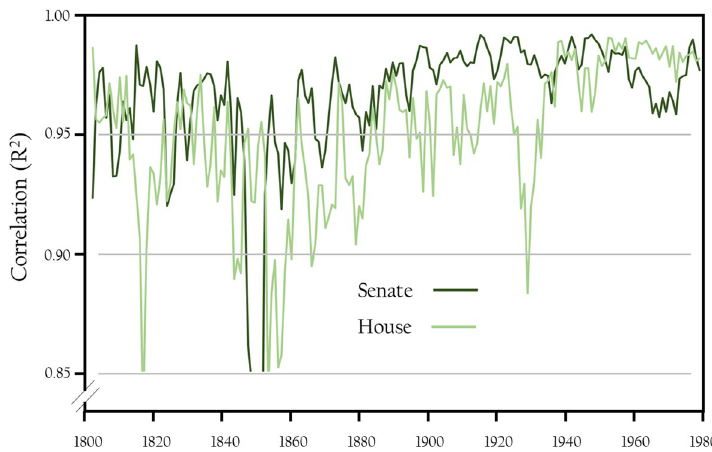
Fig. 5 Correlation coefficients ( R 2 ) for the distributions for years served relative to years remaining in the U.S. House and U.S. Senate from 1800 through 1980